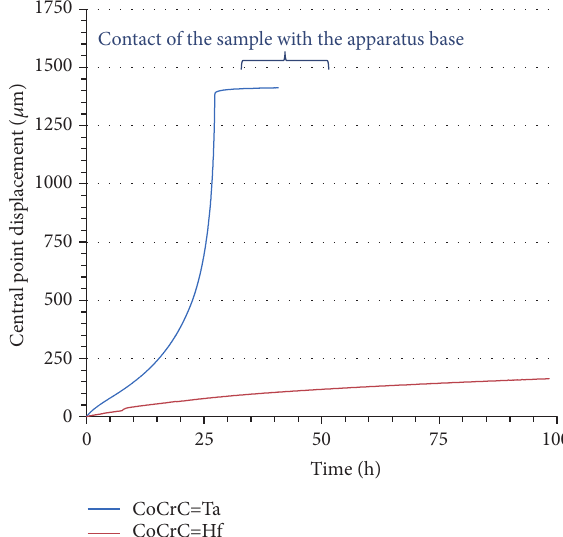
Figure 9: The deformation curves of the “CoCrC=Ta” alloy and of the “CoCrC=Hf” alloy recorded during creep tests at 1200 ∘ C under a load applied on the top middle to induce a 20 MPa tensile stress.